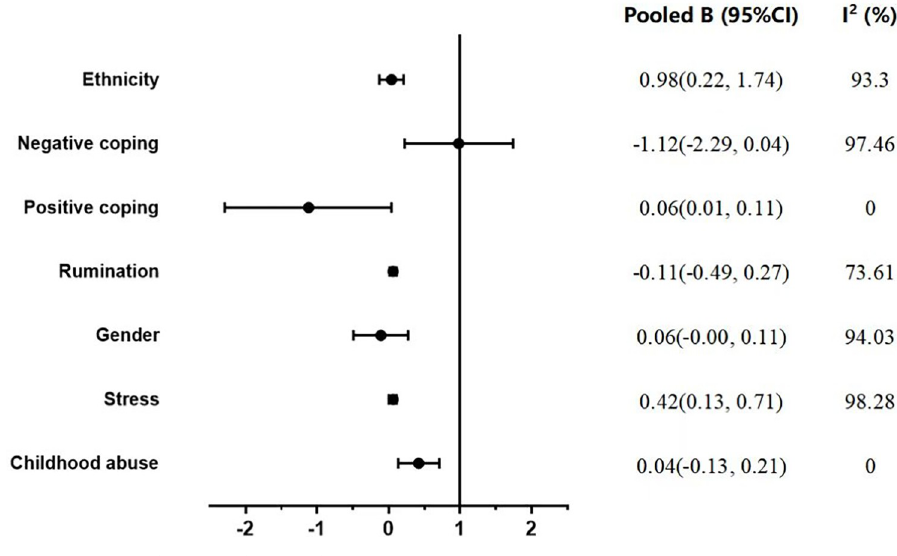
Fig 2. Summary of meta-analysis